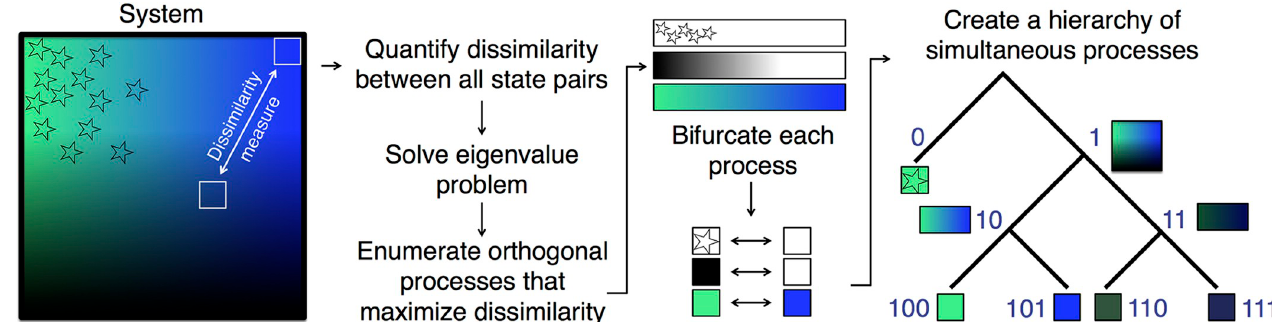
Fig 1. Conceptual scheme illustrating the sCSC algorithm. First, the dissimilarity between all pairs of states are tabulated in an adjacency matrix. For this example system, states are represented by a uniform grid of squares, two of which are illustrated in the left panel. The adjacency matrix is then used to solve an eigenvalue problem (Eq (2)) that maximizes the dissimilarity measure. The solutions to the eigenvalue problem identify orthogonal processes in the system in order of their ability to separate the system; in this case, we have stars $ no stars, bright $ dark, and green $ blue, which we have asserted are decreasingly effective in explaining dissimilarity in this notional system. These three processes are bifurcated into two extremes (middle panel). Then, each state is encoded according to each bifurcation. For the first orthogonal process (stars $ no stars), we bifurcate the entire system. For the next orthogonal process (bright $ dark), we bifurcate the system separately and illustrate only states which become bifurcated along this division. For example, there is no state that contains stars and is dark, so branch 0 of the corresponding dendrogram is not further bifurcated. Finally, we bifurcate both branches 10 and 11 according to green or blue.